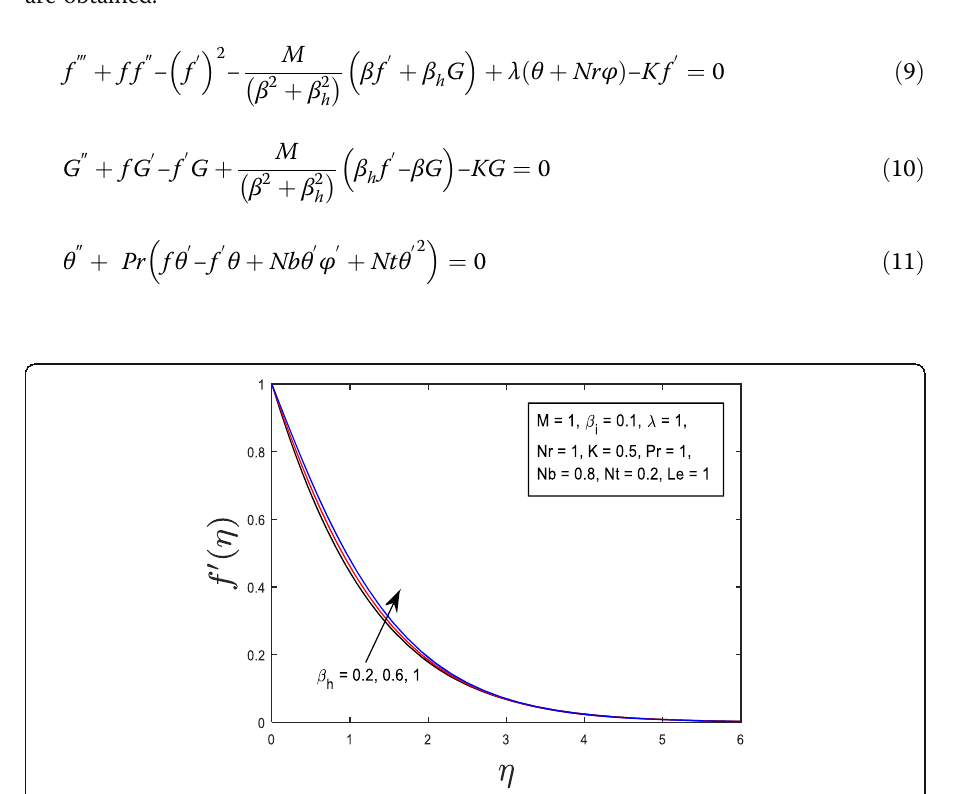
Fig. 6 Graph of velocity for various values of β